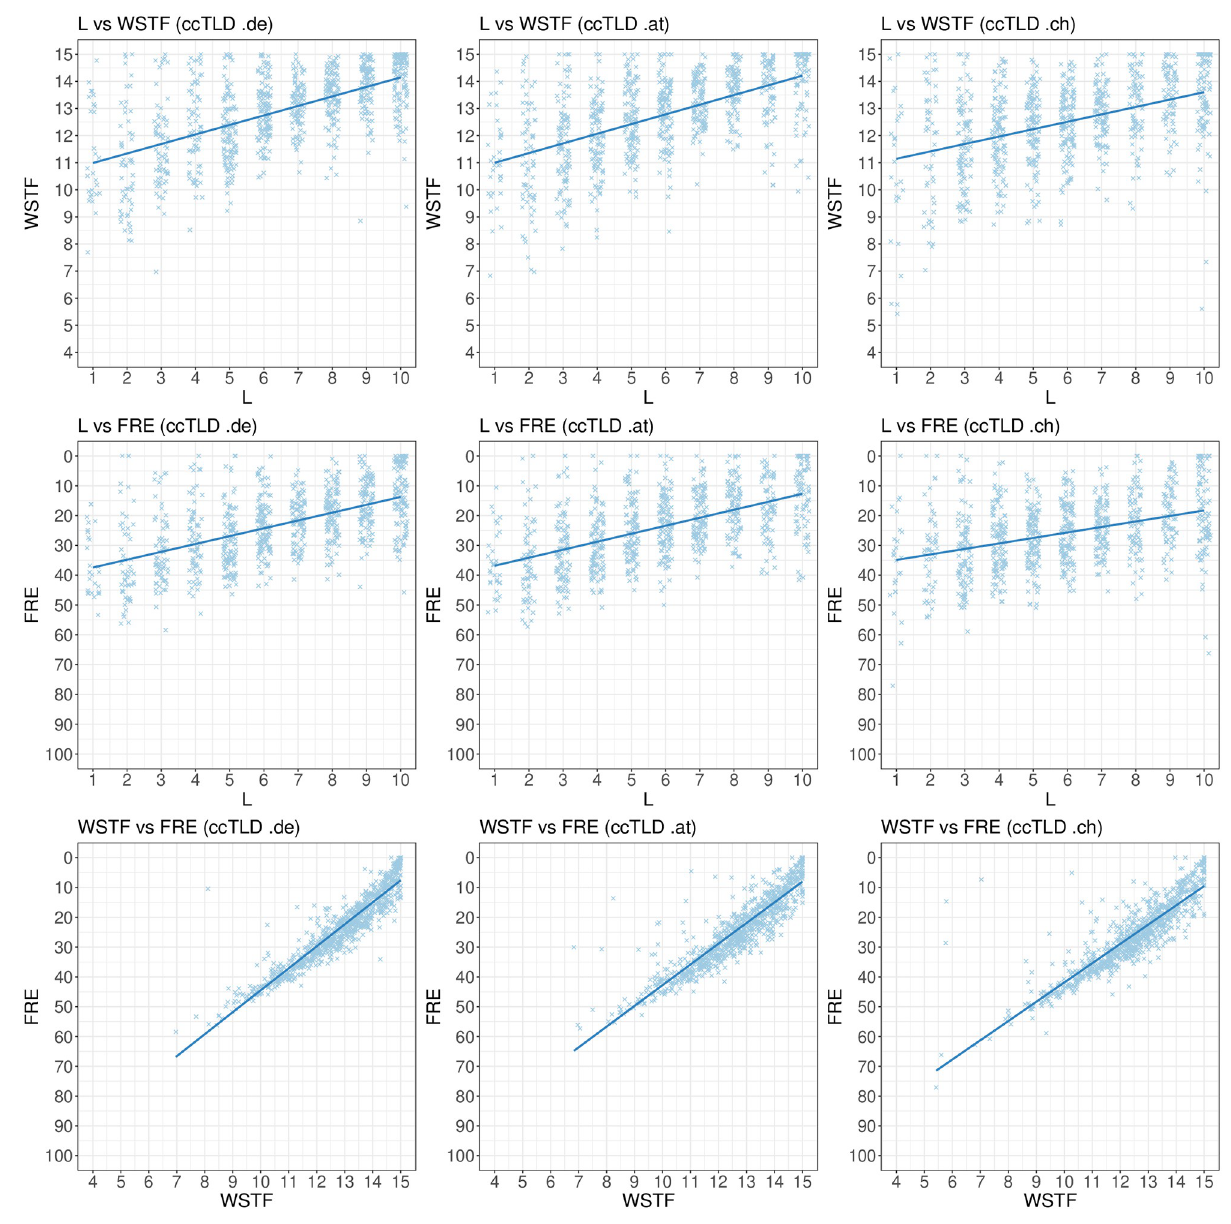
Fig 7. Scatter plot of the distributions for FRE, WSTF and L for each ccTLD.